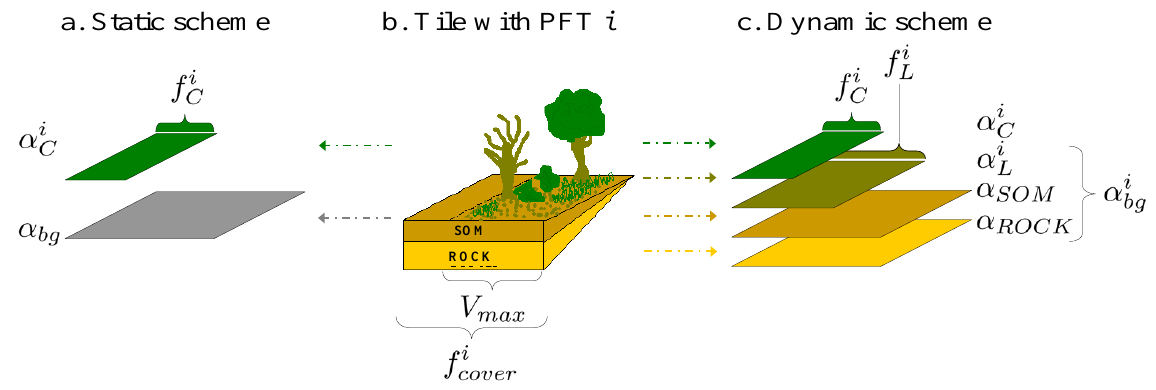
Fig. 1. Sketch illustrating the components needed to calculate α i , the land surface albedo of the tile containing PFT i according to the static (a) and dynamic (c) background albedo schemes. Arrows and colours indicate the correspondence between albedo and a modelled tile (b) . Several PFTs are depicted in this tile to illustrate the origin of the different albedo layers. Notations are as